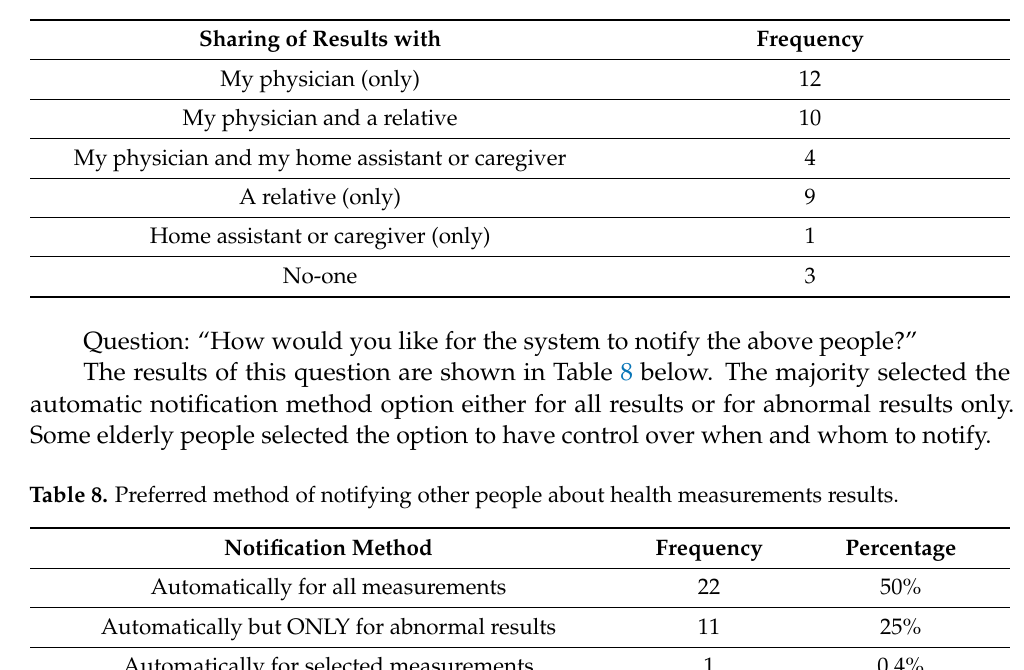
Table 7. Preferences for sharing health data with others—hypothetical scenario (select multiple answers allowed).